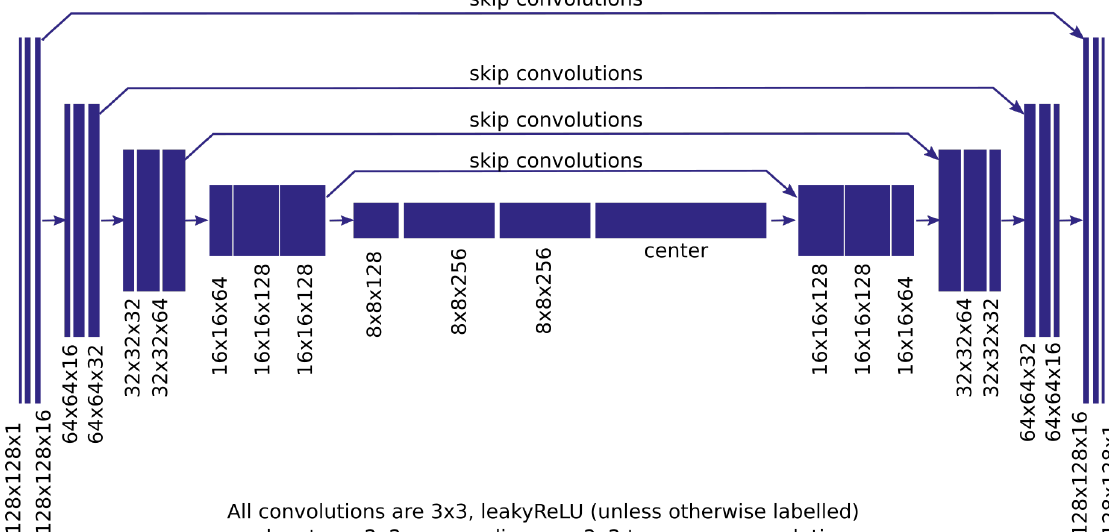
Figure 2. Visualization of the deep learning model used in the experiments: a standard U-Net structure with slight modifications to the skip connections. The (x, y, c) numbers shown represent the x and y dimensions of the layers, as well as the number of channels c . Specifically, in this figure, they show the values for a 128 × 128 input and 128 × 128 output. The center consists of an additional convolution and a skip convolution layer to enable different input and output